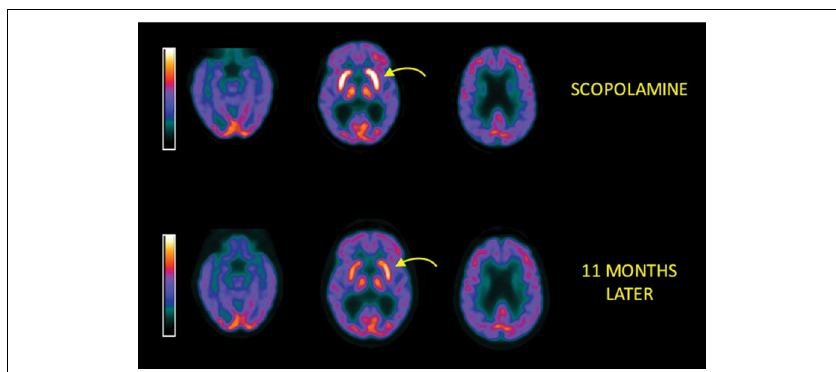
FIGURE 1 | Top: Axialbrainslicesofa2-deoxy-2-( 18 F)fluoro-D-glucosepositronemissiontomography (FDG-PET) scan dated 11/30/10: left slice = level of temporal lobes, middle = basal ganglia, right = frontal and parietal cortex. Scan shows markedly increased tracer uptake in the basal ganglia (arrow indicates left striatum), which appears striking against the normal uptake diffusely in the cortex. Basal ganglia to cortex ratio = 2.1. This finding has not been described consistently for any neurological disorder and is presumably secondary to scopolamine. Color bar indicates standardized uptake value (SUV)andrunsfrom0(black)to14(white).Onthisdisplayscale,thebasalgangliaareactually“burned out” bright, with an SUV of 20. Bottom: FDG-PET performed on 10/25/11 demonstrating essentially normaltraceruptakeinthebasalganglia(arrow)andcortex.Thebasalgangliatocortexratio = 1.5.This represents a dramatic improvement from the previous scan. The striking interval improvement in the scan supports the hypothesis that the original PET abnormality was a medication effect. Color bar indicates SUV and runs from 0 (black) to 14 (white).